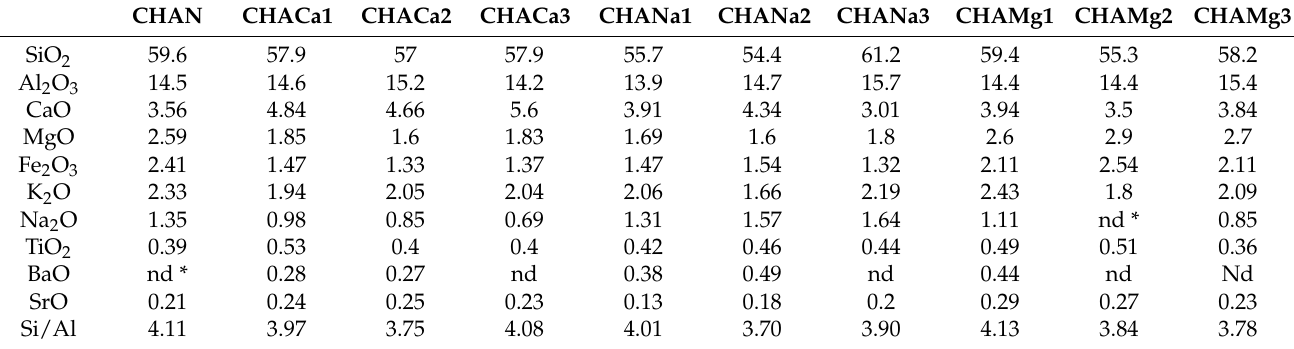
Table 3. Chemical composition (% weight) of natural (CHAN) and exchanged chabazite samples, XRF.